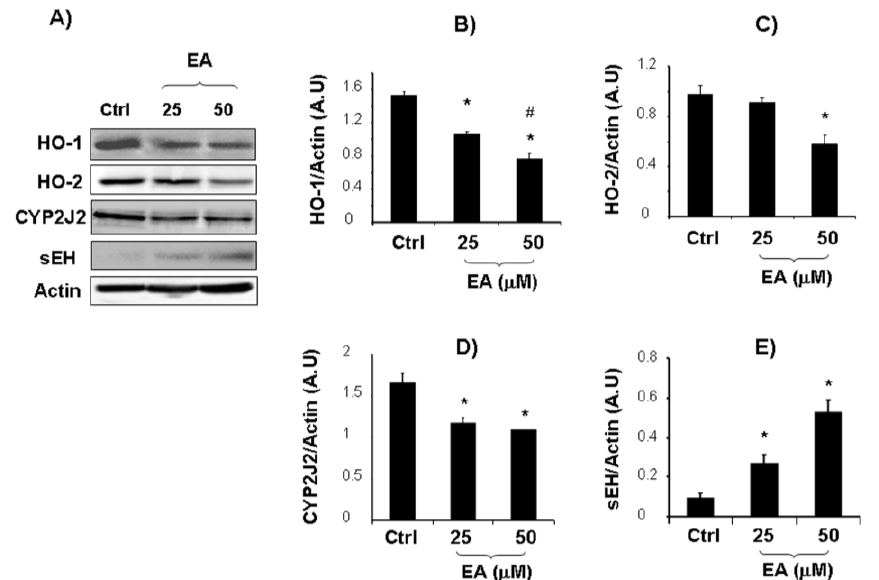
Figure 2. Effect of EA (25 and 50  M) on HO-1, HO-2, CYP2J2 and sEH expressions in cultured LnCap cells ( B–E ). Results, expressed as arbitrary units (AU), represent the mean ± SD of 4 experiments performed in triplicate. Significance of 25–50  M EA versus control; * p < 0.05. Significance of 50  M EA versus 25  M EA; # p < 0.05. Representative Western blotting of HO-1, HO-2, CYP2J2 and sEH protein expression in cultured LnCap cells ( A